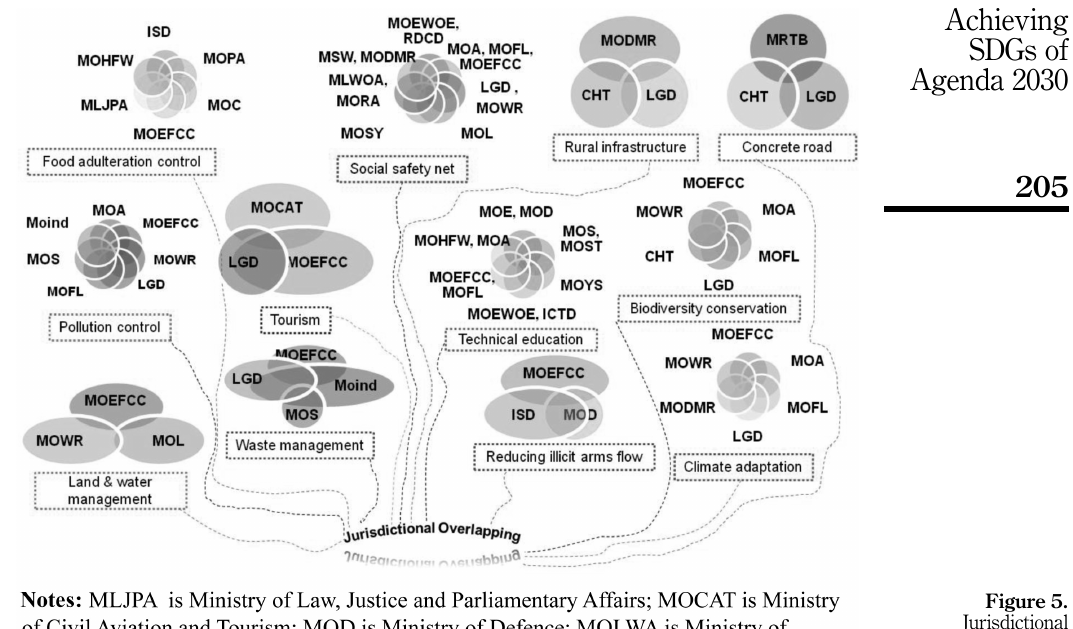
Figure 5. Jurisdictional overlapping among